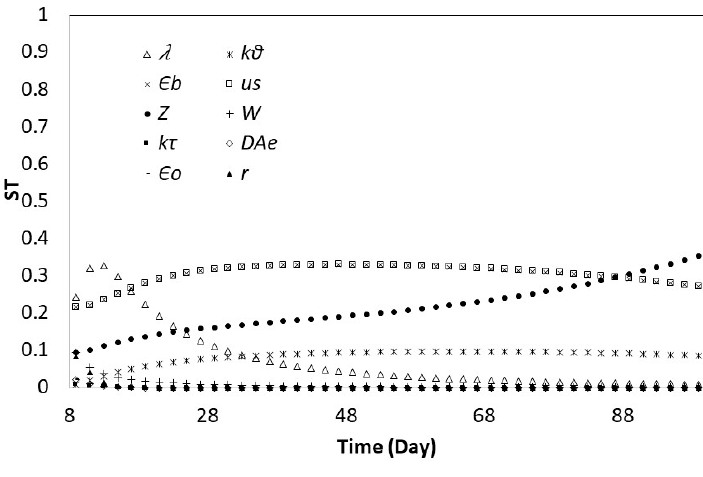
Figure 13. GSA of the model at ε o 0.01.